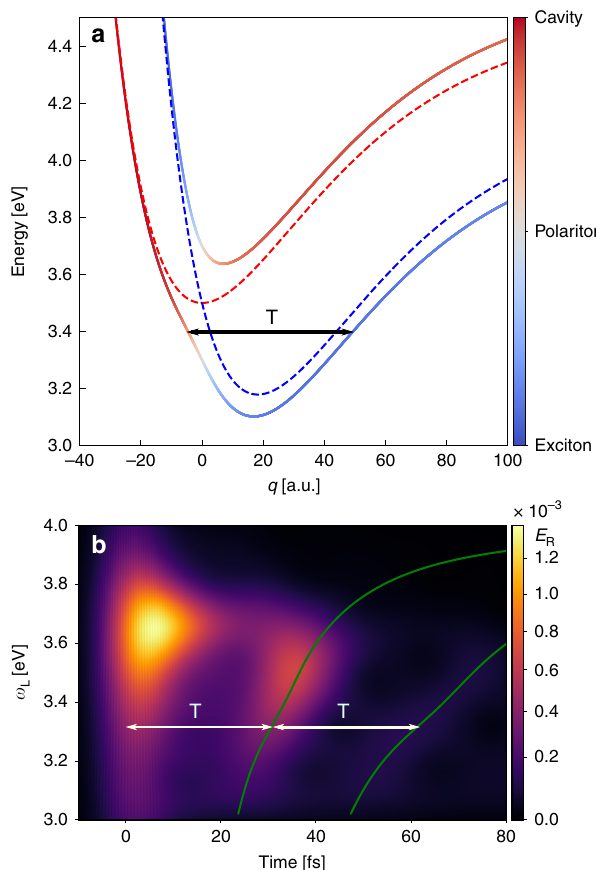
Fig. 6 Morse potential. a PoPES for a molecule where the ground and excited state are described by displaced Morse potentials. The colors and line styles have the same meaning as in Fig. 1. b Time-dependent radiative emission E R for different values of ω L and for Ω R = 0.4 eV. For all calculations, E 0 = 2.1 × 10 − 7 a.u. and σ L = 0.1 eV. The three green lines are calculated as t = nT ( ω L ), with n = 0, 1, 2 (see main